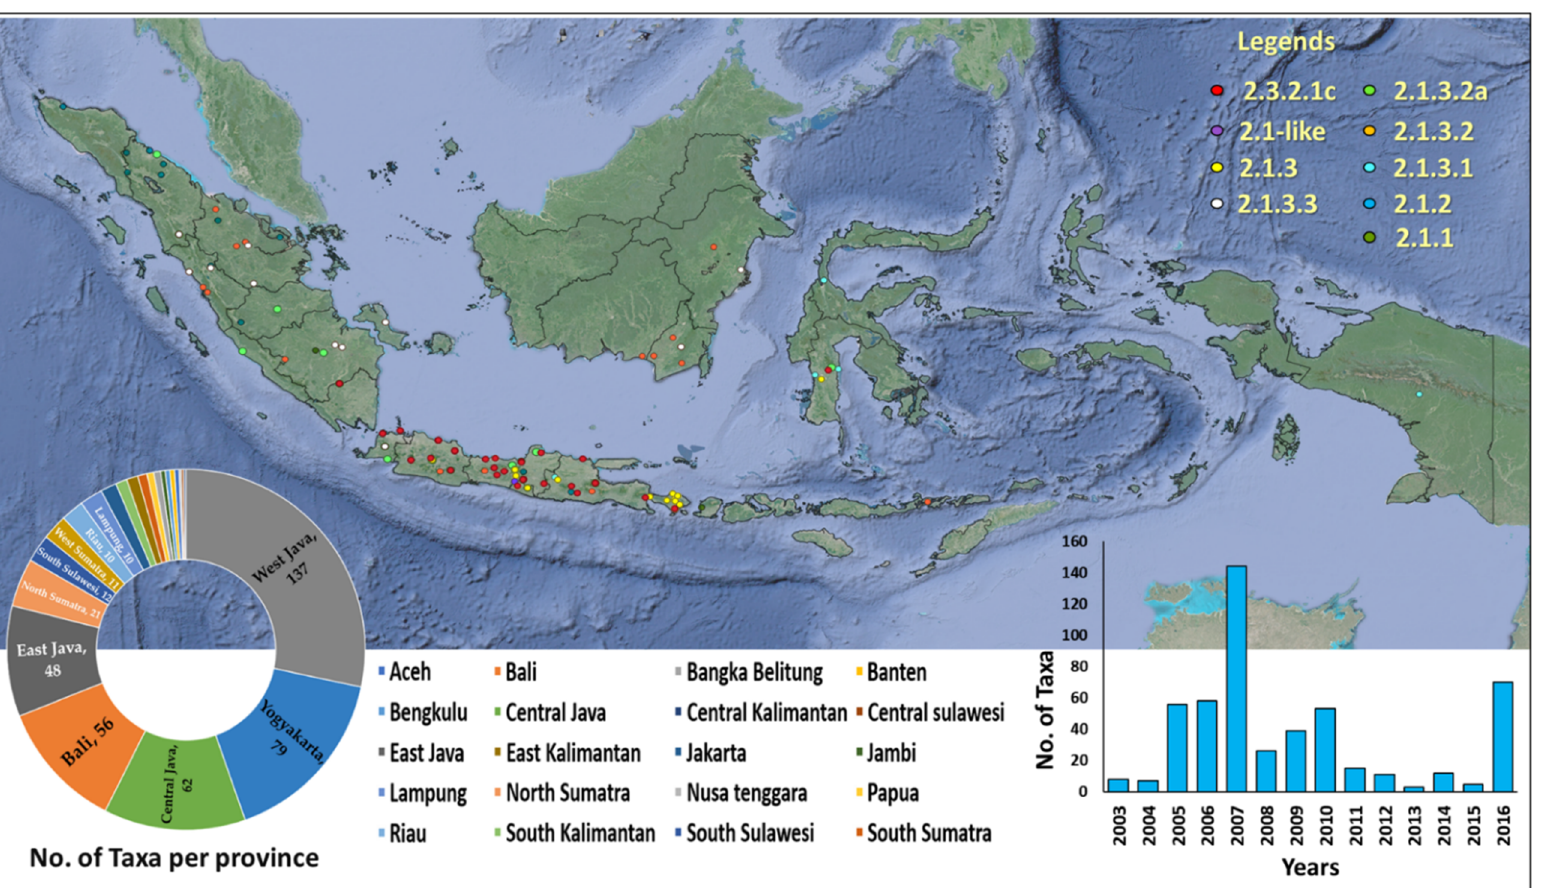
Figure 2. The distribution of HA of HPAIv A(H5N1) was detected in poultry based on different clades and different provinces of Indonesia. The number of taxa per province and per years are displayed in Supplementary Tables S2 and S3.